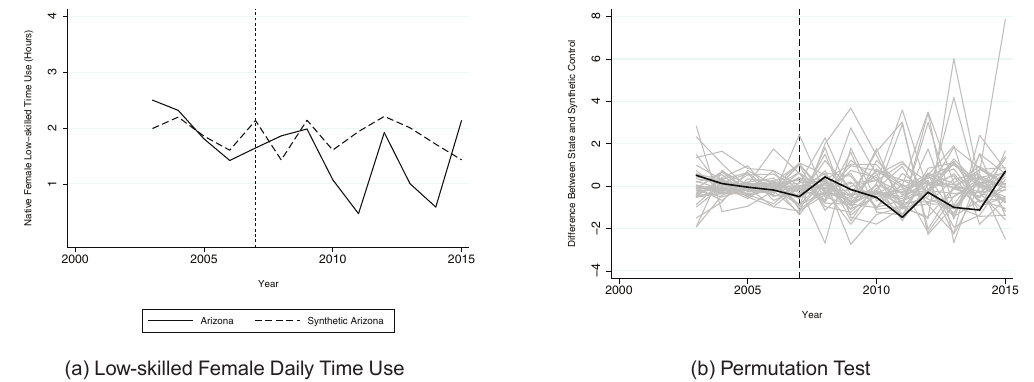
Figure 8 Native low-skilled female daily time spent on housework, gardening, and caring for children